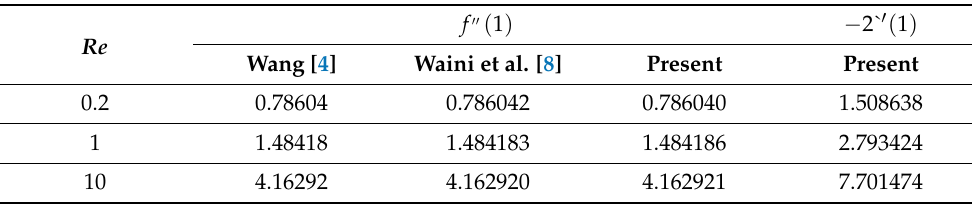
(cid:16) (cid:17) Re z C f and Nu when Pr = 6.2, and Sb = Sr = Du = Rd = 0. a Waini et al.